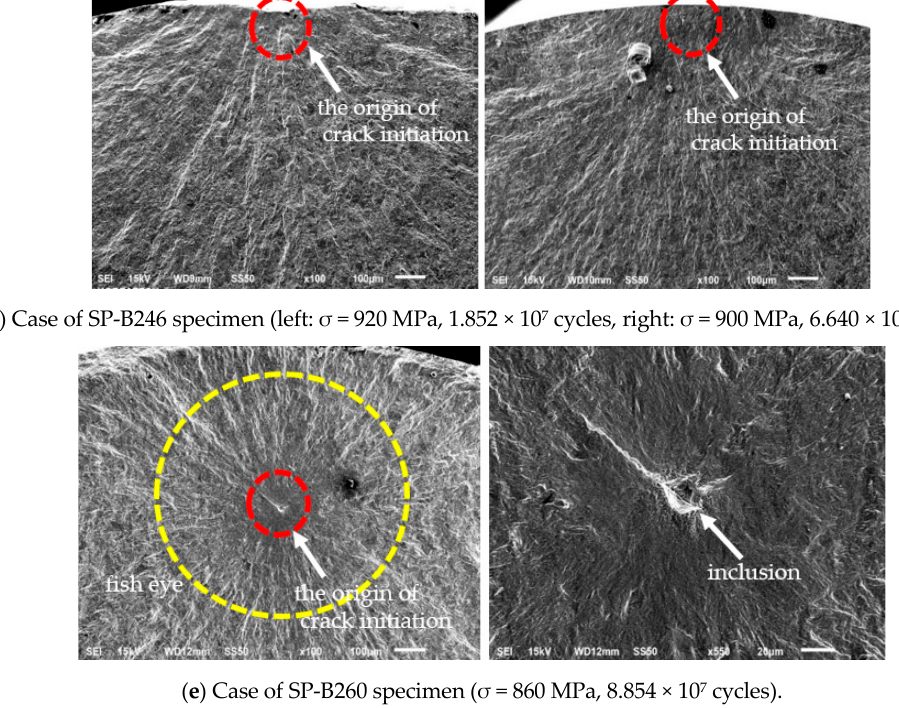
Figure 8. SEM photographs of the fatigue fracture surface obtained from the ultrasonic fatigue test.